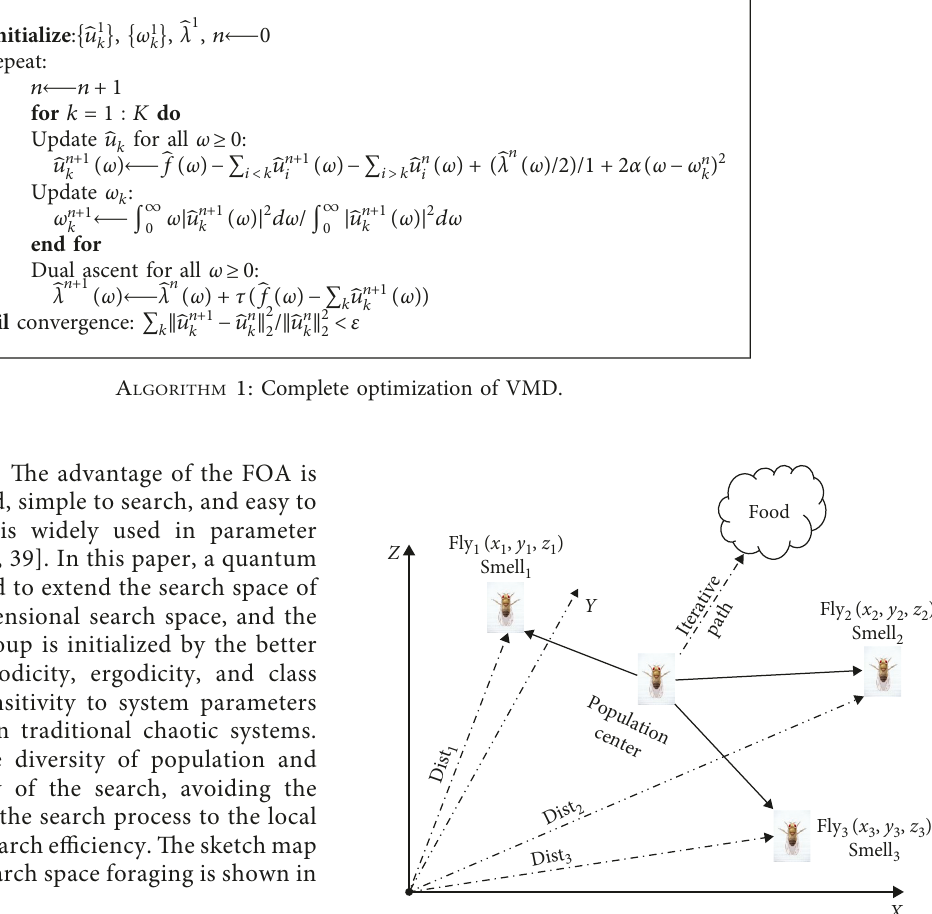
Figure 1: Three-dimensional space foraging map of the fruit fly